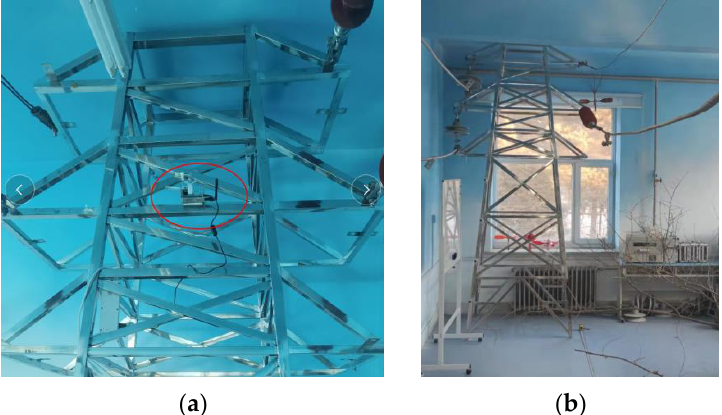
Figure 10. Experimental environment construction: ( a ) Indoor monocular vision camera setting; ( b ) The picture was taken by monitoring